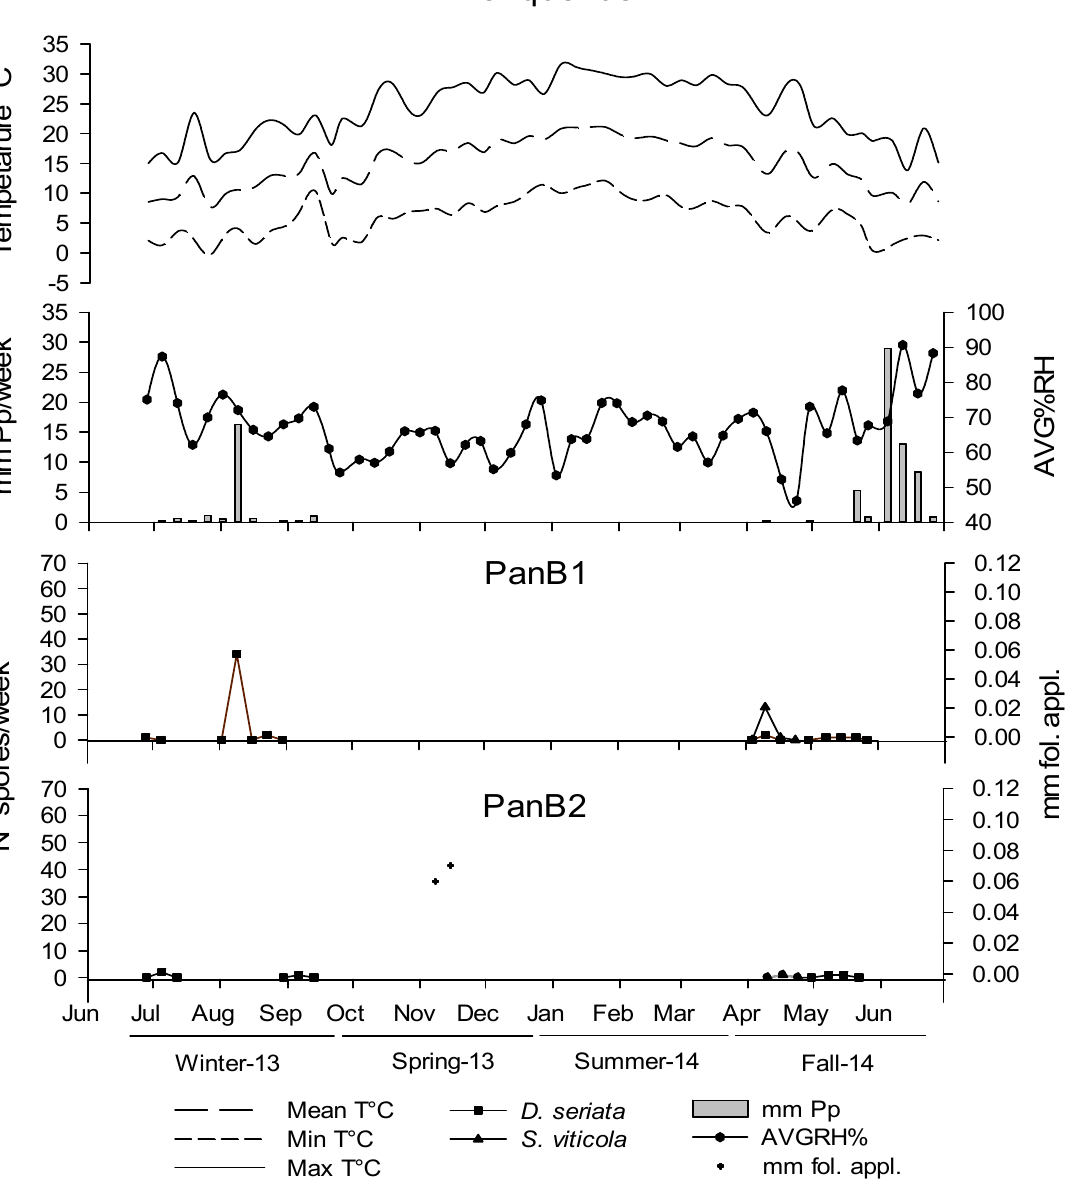
Figure 3. Weekly records of numbers of spore–trapped conidia of Diplodia seriata , Spencermartinsia viticola and Neofusicoccum sp. in two vineyards (PanB1, PanB2) in Panquehue, Valparaíso Region, Chile. Cardinal temperatures, relative humidity (diamond symbols) and accumulated precipitation (histogram bars) recorded during the experimental period are plotted at the top of the